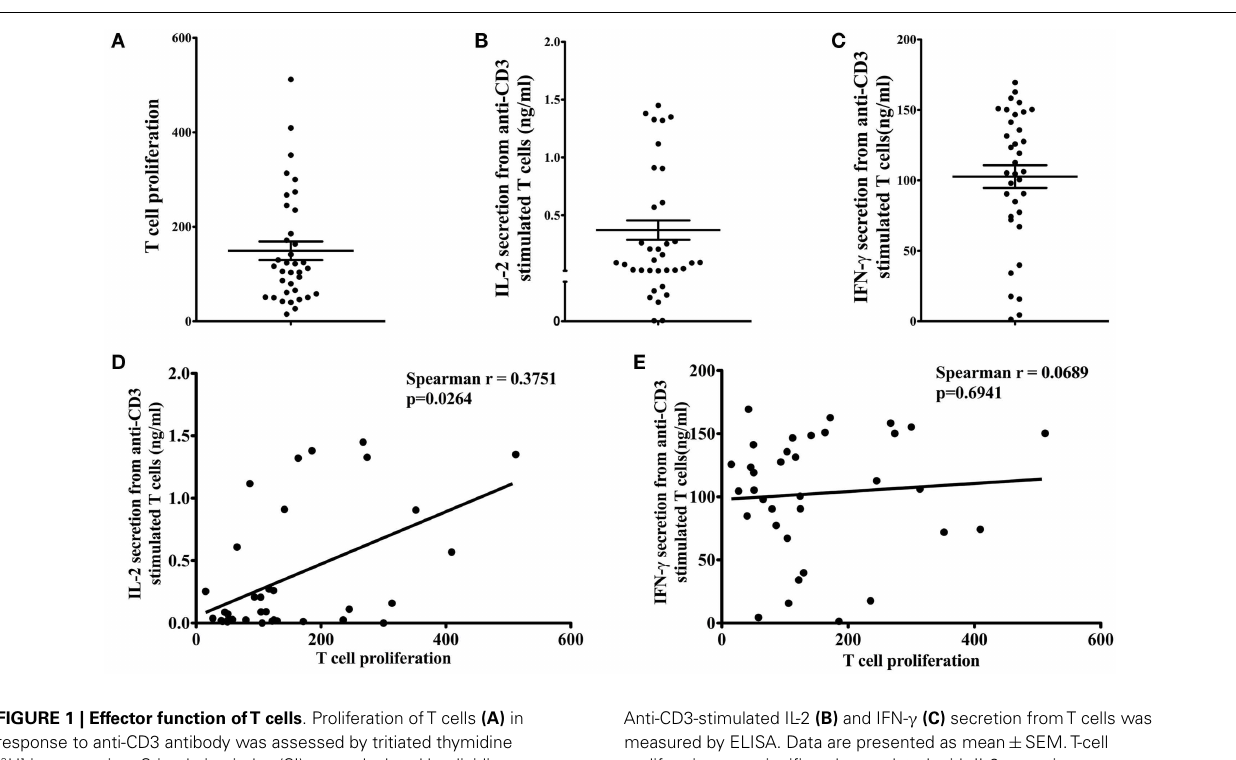
FIGURE 1 | Effector function ofT cells . Proliferation ofT cells (A) in response to anti-CD3 antibody was assessed by tritiated thymidine [ 3 H] incorporation. Stimulation index (SI) was calculated by dividing the mean cpm of stimulatedT cells (in response to 1 µ g/ml anti-CD3) by the mean cpm of unstimulated cells (in media alone).